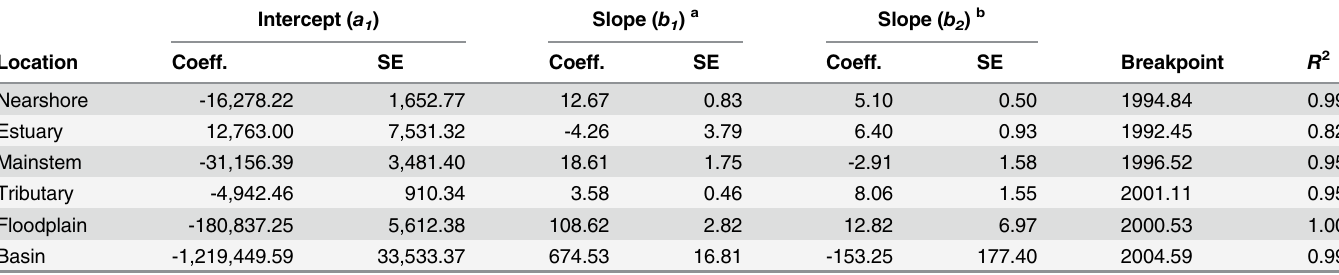
Table 4. Segmented Regression Analysis Results: Puget Sound Scale. Intercept ( a 1 ) Slope ( b 1 ) a Slope ( b 2 ) b Location Coeff. SE Coeff. SE